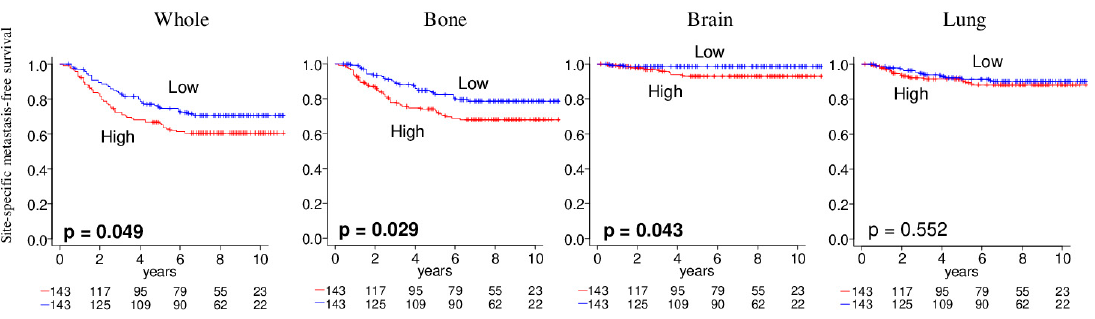
Figure 6. Association of the angiogenesis pathway score with metastatic recurrence in breast cancer. The Kaplan–Meier survival plots of metastasis-free survival for metastasis to bone, brain, or lung based on the pre-metastasis primary tumor in GSE2034 cohort ( n = 286). The median was used as cut-o ff to divide into high (red) and low (blue) score groups within each cohort. To calculate p values, log rank test is used for comparing between two groups with Kaplan–Meier survival curves.